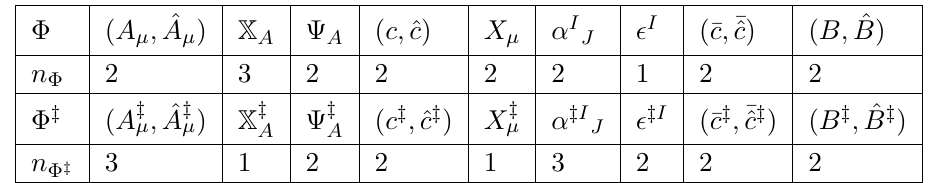
Table 3 . Fields, anti-(cid:12)elds and their weights n (cid:8) ; n